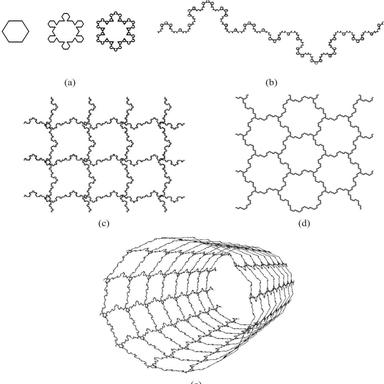
Composite Koch fibers and meshes.